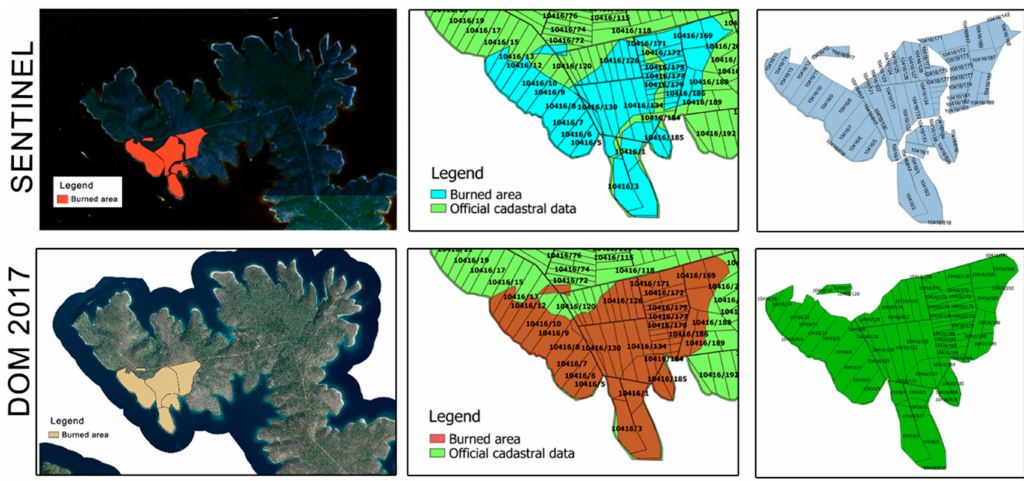
Figure 5. Resulting intersection of the burned area and cadastral parcels. Image showing the resulting intersection obtained from the Sentinel satellite images and from a digital orthophoto map (DOM).